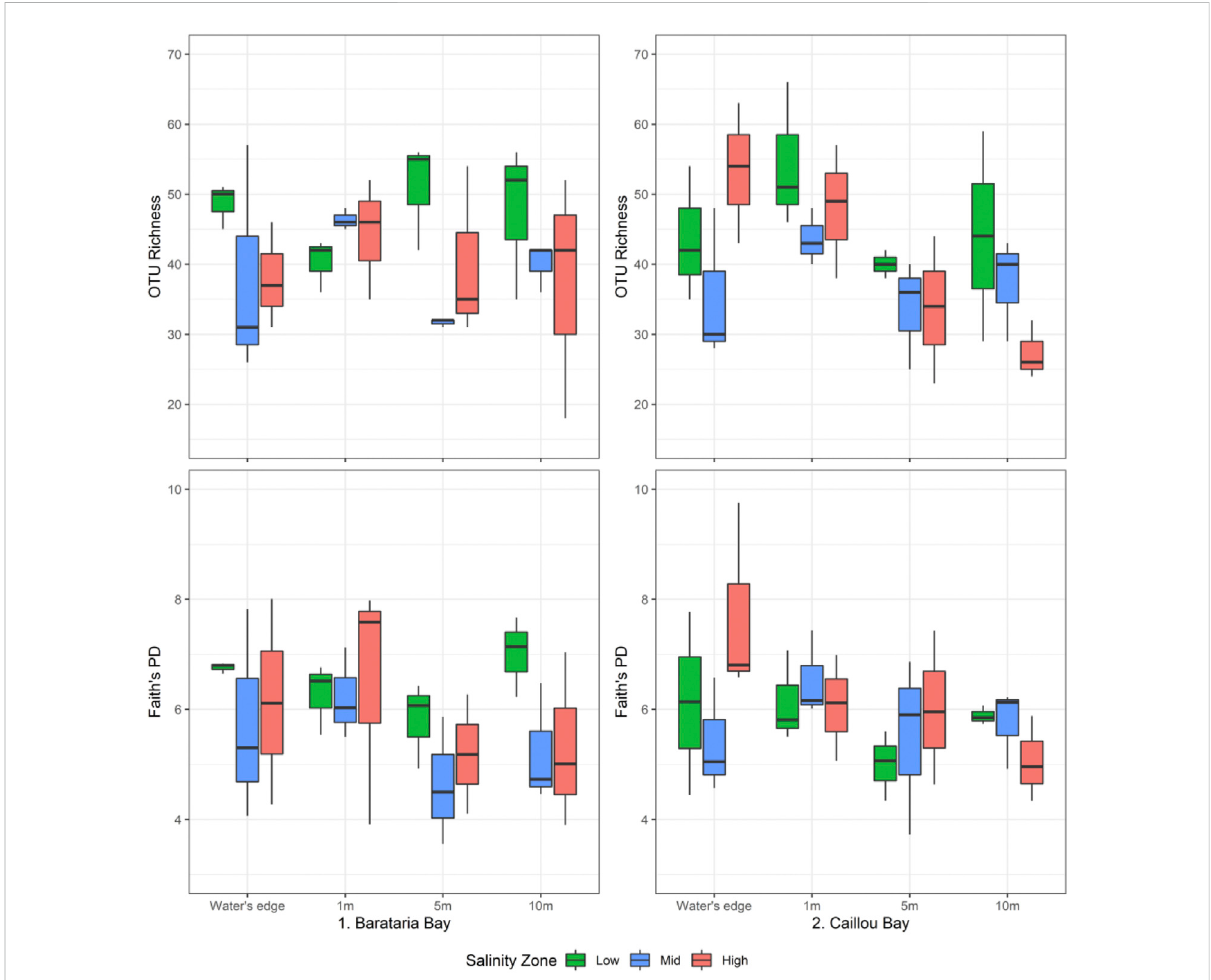
FIGURE 3 Boxplots of metazoan OTU richness (top) and Faith ’ s PD values (bottom), divided by bay, salinity zone, and distance from marsh edge.